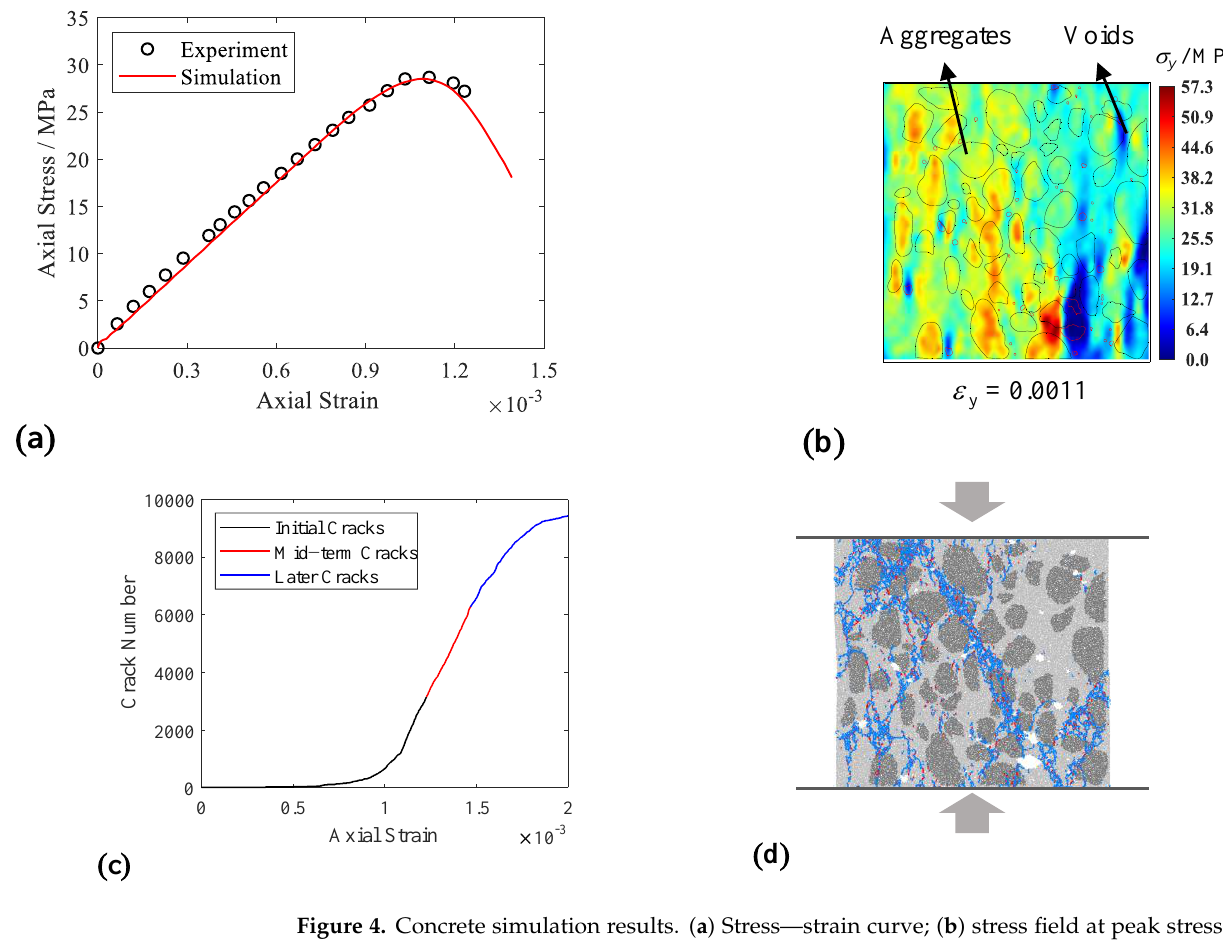
Figure 4. Concrete simulation results. ( a ) Stress—strain curve; ( b ) stress field at peak stress state; ( c ) crack number — strain curve; ( d ) failure surface.